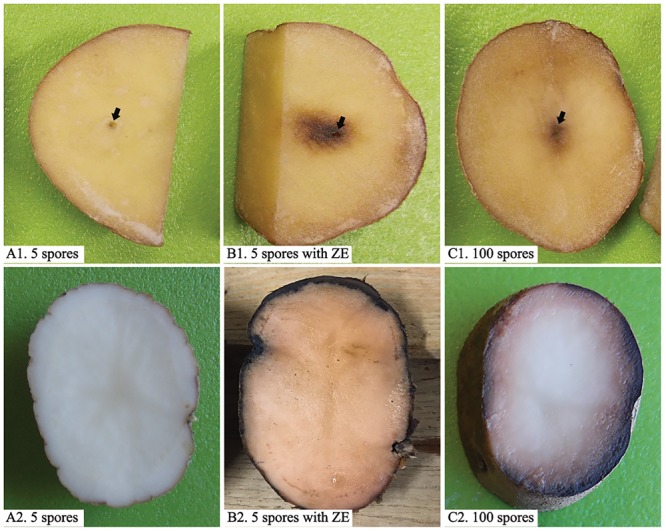
Inoculation of potato tubers (cv. “Russet Norkotah”) with Phytophthora erythroseptica zoospores. Either tuber slices (upper panels) or whole tubers (lower panels) of potato were inoculated with 5 zoospores suspended in 10 μl sterile distilled water (A1,A2), 5 zoospores suspended in 10 μl exudate derived from high-density zoospore suspension (1 × 104 spores/ml) (B1,B2), and 100 zoospores suspended in 10 μl sterile distilled water (C1,C2). Arrows indicate inoculation position.